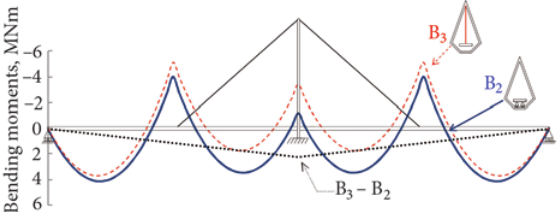
fig. 3. Bending moments in the girder in the OSS obtained in B 2 and B 3 and differences between both bridges. The diagram of B 3 corresponds with the target continuous beam B